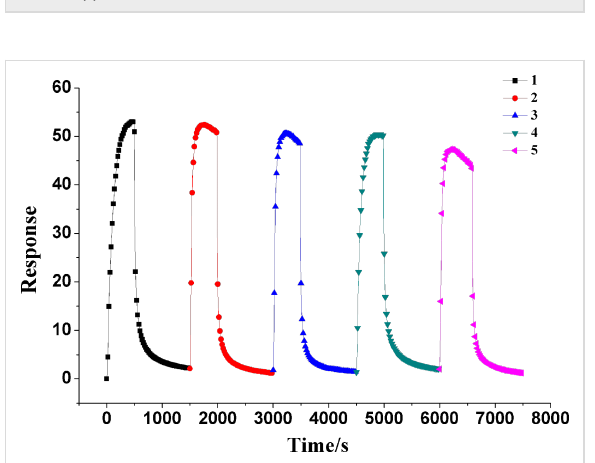
Figure 9: Sensing repeatability and reversibility of In 2 O 3 /PANI-2 nano- fibers sensor to 1000 ppm NH 3 vapor.